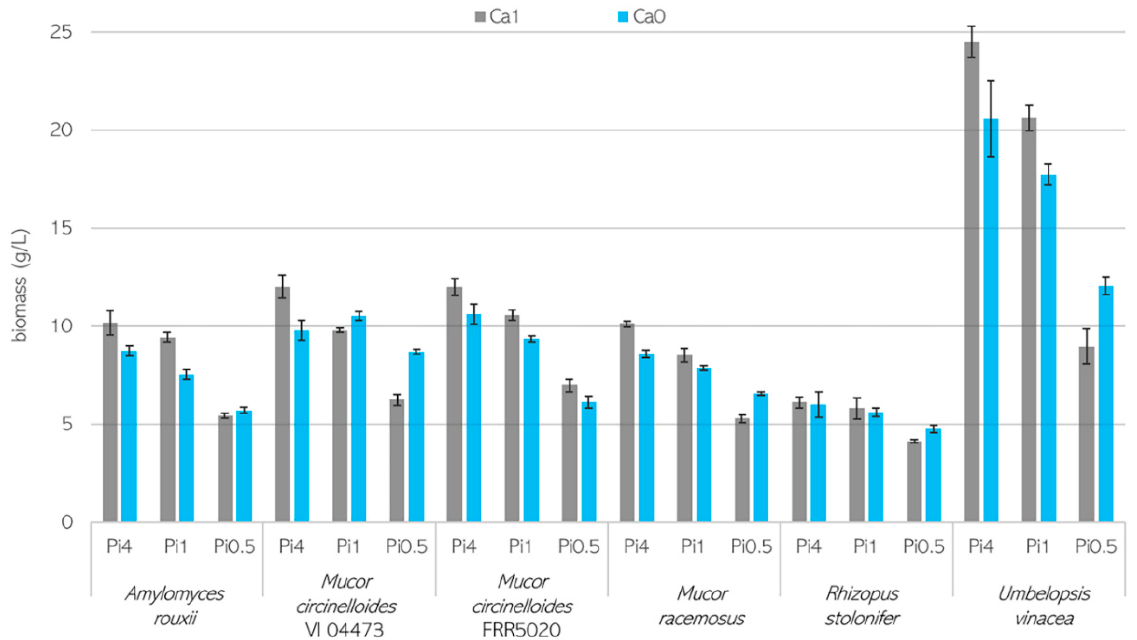
Figure 1. Biomass concentration (g/L) of fungi grown in the presence (Ca1, grey) and absence (Ca0, blue) of calcium under three phosphorus substrate levels (Pi4, Pi1, and Pi0.5). The biomass concentration data represent the average of 4 bio-replicates, and error bars show the standard deviation.